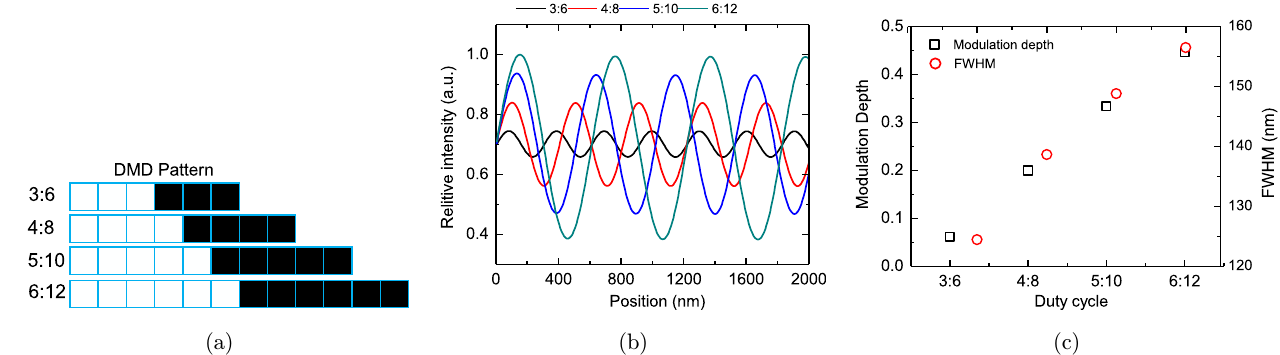
Fig. 3. Evaluation of the fringe period on the modulation depth and image resolution. (a) Binary patterns loaded on the DMD chip with di®erent periods; (b) normalized intensity distribution obtained at the focal plane of the objective; (c) modulation depth and resolution (FWHM) with di®erent fringe